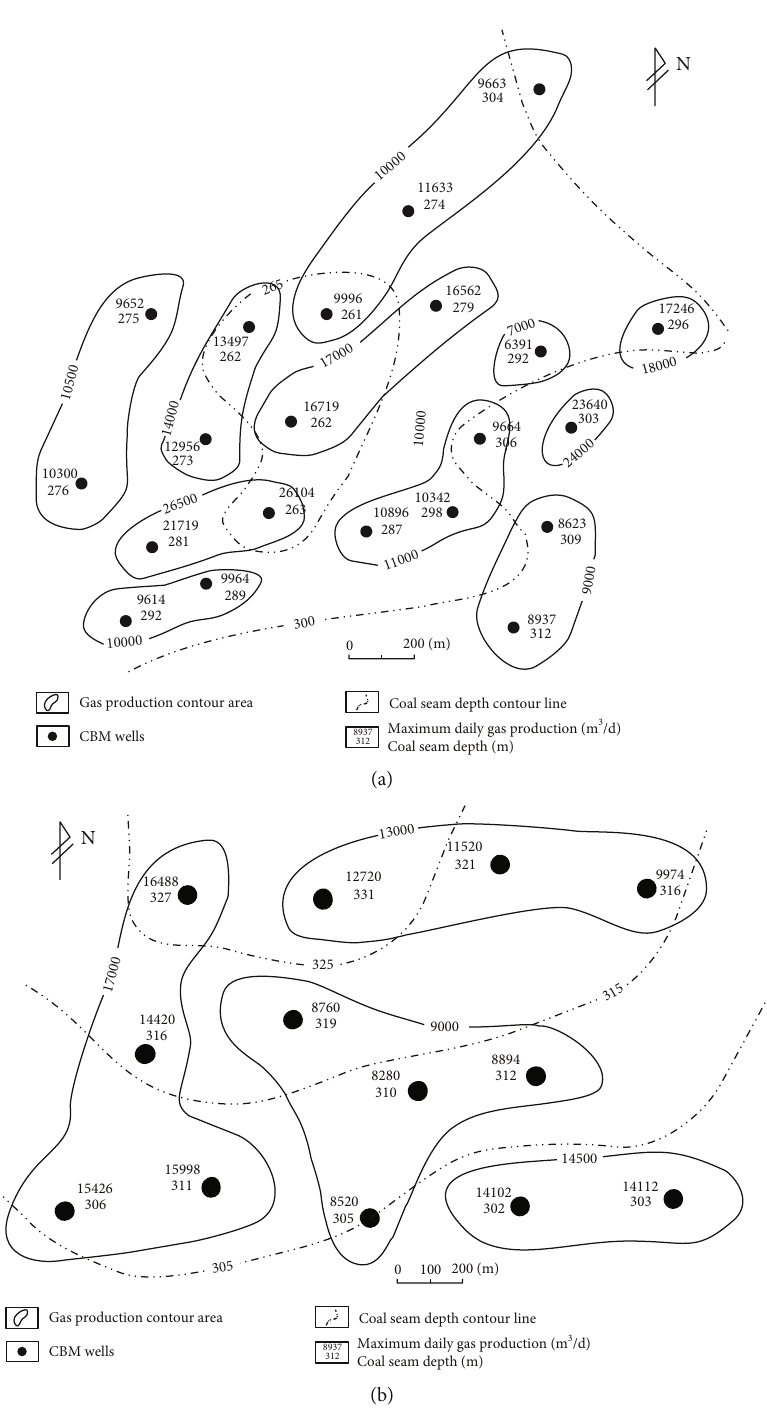
Figure 6: Coal seam maximum dairy production distribution: (a) bounded type; (b) L-type and